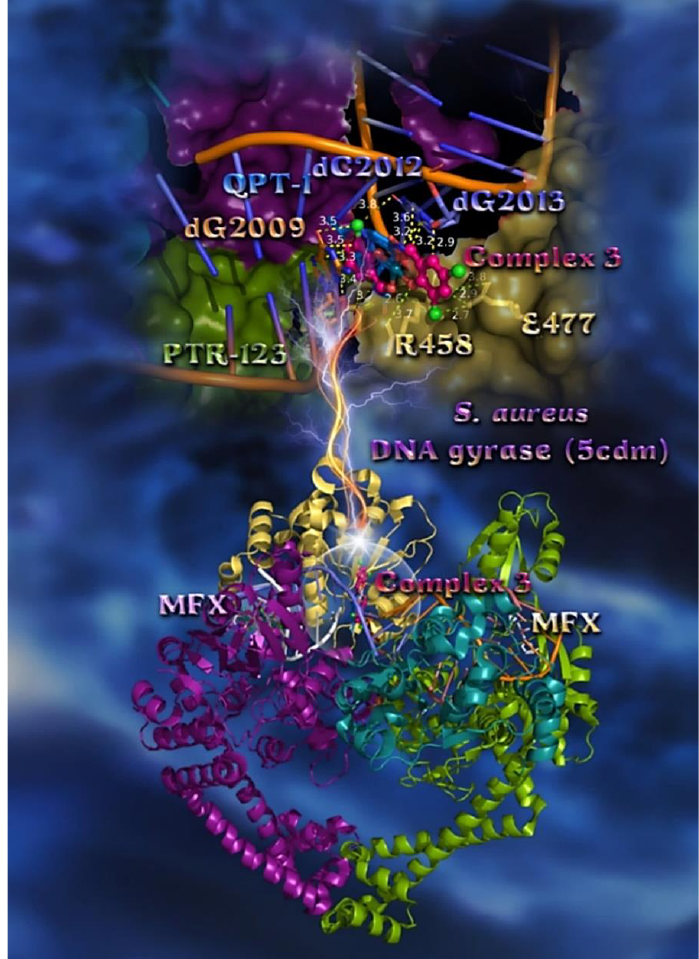
Figure 9. ( Lower panel ) Docking pose orientation of best (lowest Δ G bind energy) bound complex 3 in the crystal structure of S. aureus DNA-gyrase (PDB ID: 5cdm). Superimposed are also illustrated the active against S. aureus DNA-gyrase drugs MFX (docked) and QPT-1 (co-crystallized). MFX is docked in two binding poses (one lower and one higher binding energy) at the same binding pocket of the protein at the edge of DNA, while complex 3 is anchored at the same binding pocket with the co-crystallized drug QPT-1. The target protein is illustrated as a cartoon with sub-domains color-coded in split pea green, deep teal, deep purple, and yellow-orange colors for chains A, B, C, and D, respectively. An artificially nicked double-stranded DNA interacting with DNA gyrase is also depicted in a cartoon colored in salmon and orange for complementary strands E and N, and white and slate blue for complementary strands F and I. Docked molecules rendered in ball-and-stick and stick (complex 3 and drugs, respectively) model are colored according to atom type in hot pink ( 3 ), marine blue (QPT-1), and white and light pink (lowest and higher binding energy poses of MFX, respectively). The L-peptide linking amino acid residue o-phosphotyrosine (in split pea green sticks) is also shown in the structure. ( Upper panel ) A close-up view of the binding of 3 in both DNA and DNA-gyrase complex structure, depicting the extent of the binding pocket as determined by the computation process and the crystal structure as well. Double-stranded DNA and DNA-gyrase are depicted in a cartoon and the opaque surface, respectively, colored in the same scheme as in the lower panel. Molecular docking simulations of all molecules were performed individually. Binding contacts are shown as dotted yellow lines. Heteroatom color-code: O: red, N: blue, Cl: chartreuse green, and Pd: deep teal. Hydrogen atoms are omitted from all molecules for clarity. The final structure was ray-traced and illustrated with the aid of PyMol Molecular Graphics Systems. Binding interactions are shown in Table